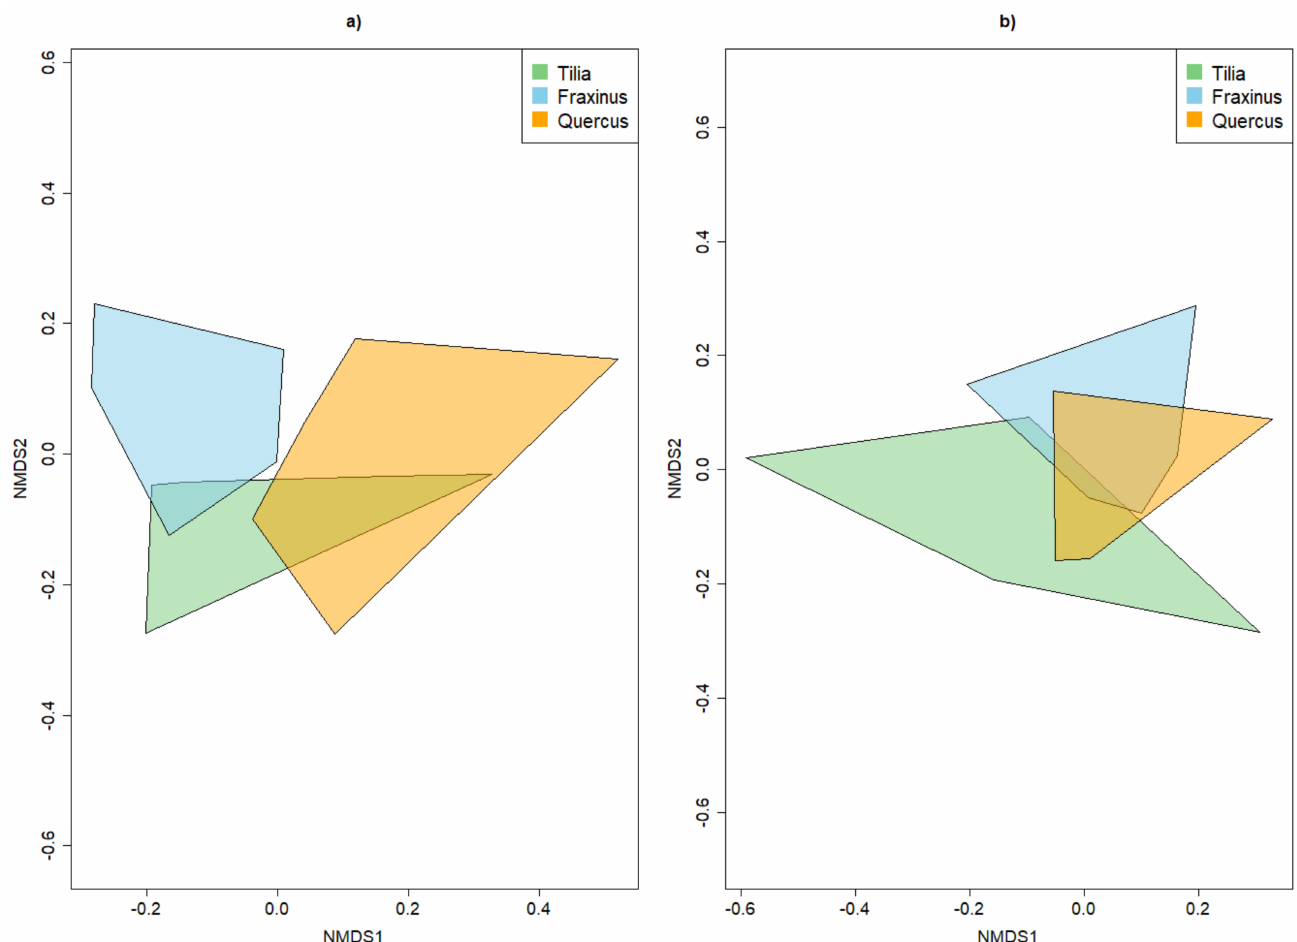
Figure 4. NMDS plot demonstrating the influence of tree species on the overall beta diversity for common beetle species ( a ) and only the rare beetle species ( b ), according to the red list